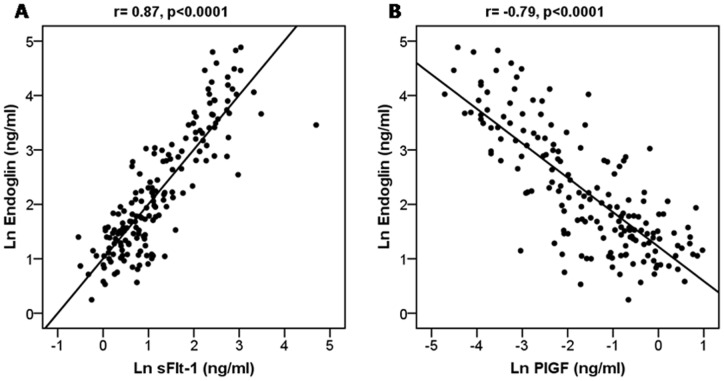
Correlation between sFlt1 and sEng (panel A) and between PlGF and sEng (Panel B).Variables were natural log transformed and p-values were derived from Pearson correlation coefficients.